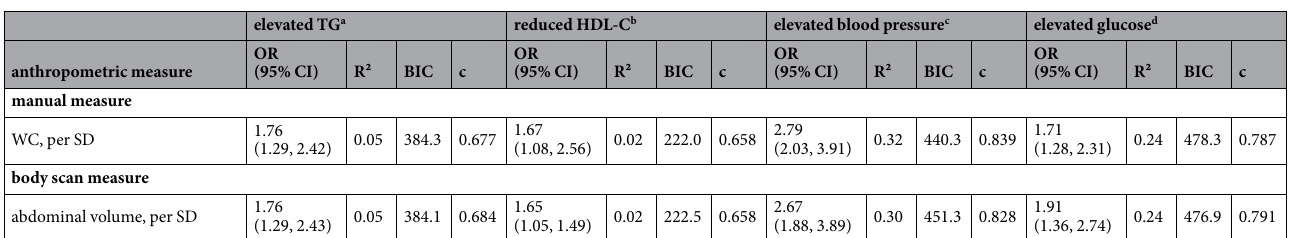
Table 4. Association of manually measured waist circumference and body scanner-based abdominal volume with likelihood of components of the Metabolic Syndrome, total (N = 411) 1 . BIC, Bayes Information Criterion; c, c-statistic; HDL-C, high-density lipoprotein cholesterol; OR, odds ratio; SD, standard deviation; TG, triglycerides; WC, waist circumference; 95% CI, 95% confidence interval 1 Results were derived from eight different multivariable logistic regression analyses with either manually measured waist circumference or body scanner-based abdominal volume included as independent variable. Components of the Metabolic Syndrome were included as single dependent variable. β -coefficients can be interpreted as difference in the likelihood (odds ratio, OR) of metabolic parameters outside the reference range, referring to one standard deviation difference in the anthropometric measure. Model adjusted for sex, age, and body height (manual measurement). a ≥ 1.7 mmol/L 5 b men, < 1.0 mmol/L; women, < 1.3 mmol/L 5 c systolic blood pressure ≥ 130 mmHg or diastolic blood pressure ≥ 85 mmHg (mean of the last two out of three sitting blood pressure measurements) or reported history of hypertension 5 d ≥ 5.6 mmol/L (or, if information on glucose is missing, HbA1c ≥ 38.8 mmol/mol) or reported history of diabetes 5